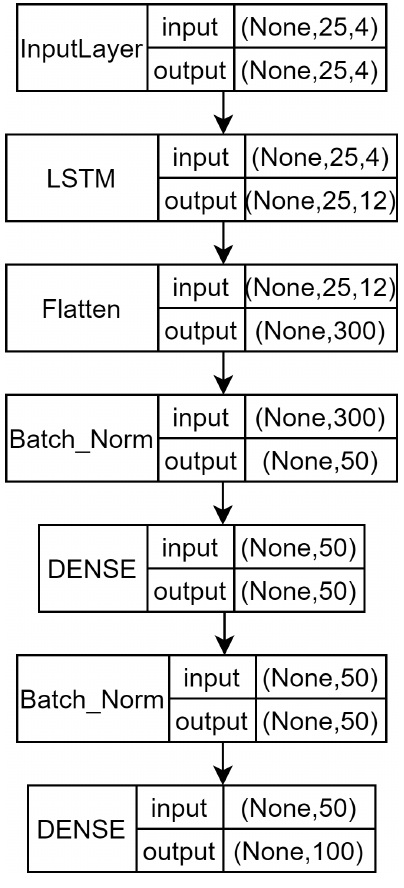
Figure A9. Mayo’s architecture block